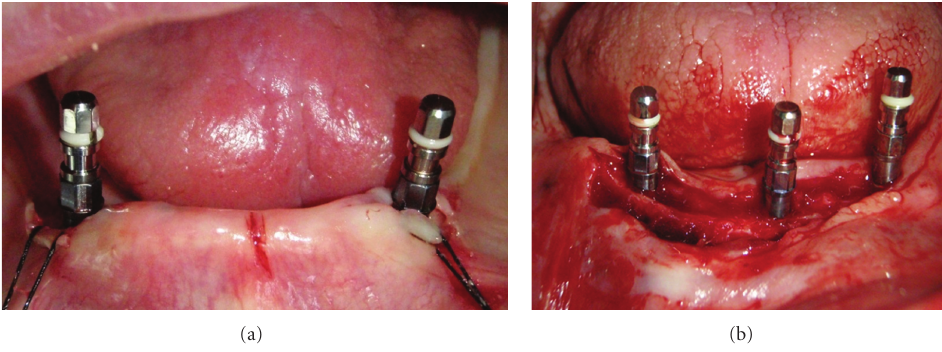
Figure 1: Surgical placement of the implants in the mandible.